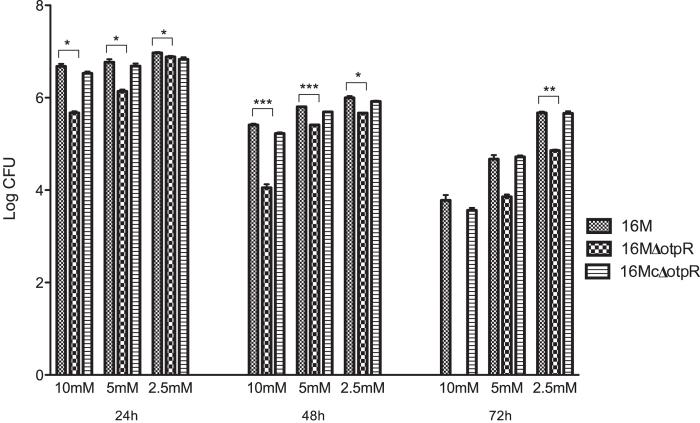
Survival of B. melitensis 16 MΔotpR, 16 McΔotpR, and the wild-type strain under iron-limited conditions.The survival of the strains was measured in the TSB medium containing 2.5 mM, 5.0 mM and 10.0 mM Fe2+ chelator 2,2`-dipyridyl. The measurements were taken at 24 h, 48 h and 72 h after inoculation. Experiments were performed in triplicates and a significant difference was observed. Statistical analysis was performed by comparing the CFUs of 16 M versus 16 MΔotpR bacteria at different time points using the Student’s t-test. p < 0.05 (*), p < 0.01 (**) and p < 0.001 (***) represents different levels of significant differences. It is noted that in the presence of 10.0 mM DIP, the otpR mutant could be detected at 24 and 48 h after inoculation, but not at 72 h. When the CFU/mL was determined, 200 μL of culture sample was used in each condition, which equals to a detection limit of 5 CFU/ml (or ~0.7 LOG CFU). It is possible that there were still some viable otpR mutant cells survived in the iron-limited medium at 72 h; however, the level of survival was below the laboratory’s detection limit.